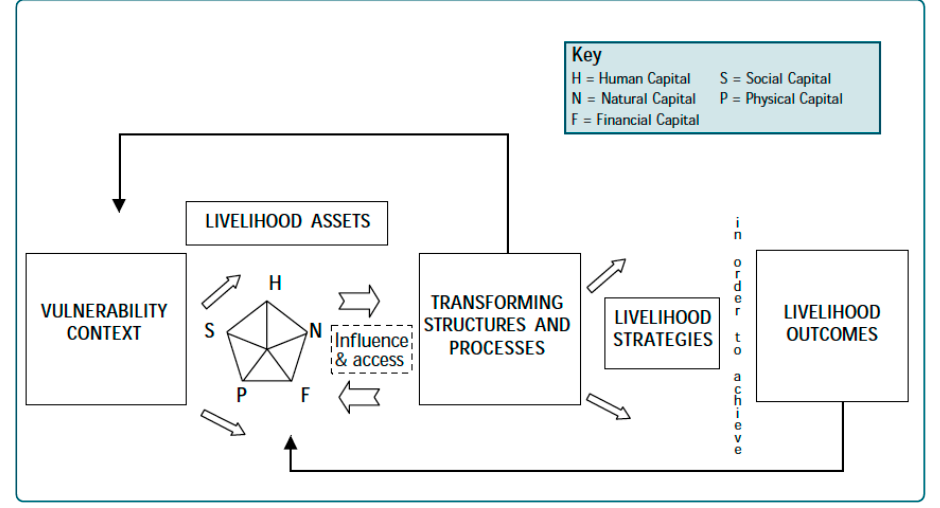
Figure 1. Sustainable livelihoods framework (SLF). Source: [6].